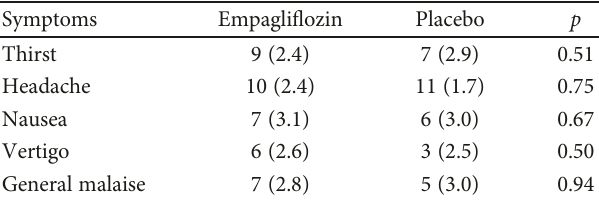
Table 2: Number of participants who experienced symptoms attributable to hyponatremia during the study with the according average score of symptom severity on visual analogue scale in brackets (range 0 =no symptoms to 10=severe